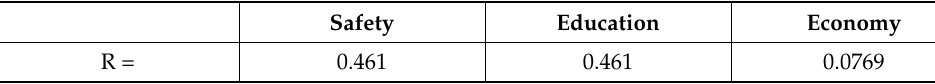
Table 7. 3 Component Vector Weights for the 3 Criteria.